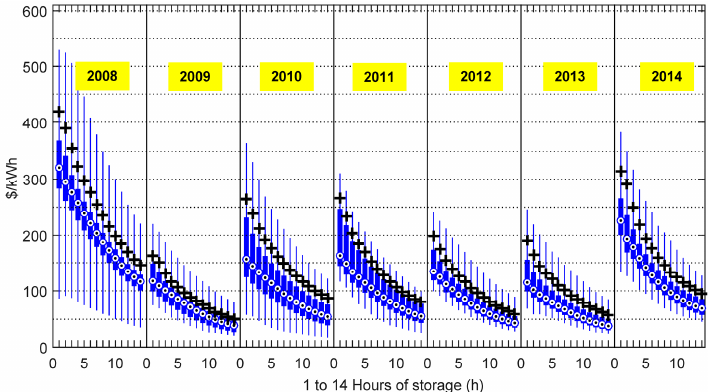
Figure 25. Distribution of breakeven overnight installed cost using DA prices as forecast for dispatch in the PJM RT-Market for an ESS vs. discharge duration at rated power (1–14 h) for each of the years studied. The thin vertical bars represent the entire range over the 7395 nodes. The thick vertical bars are bounded by the 25th and 75th percentile of the nodes. The circles represent the 50% percentile of the nodes and the black crosses indicate the 95th percentile of the nodes. Assumed round trip efficiency is 90% and project lifetime is 20 years.